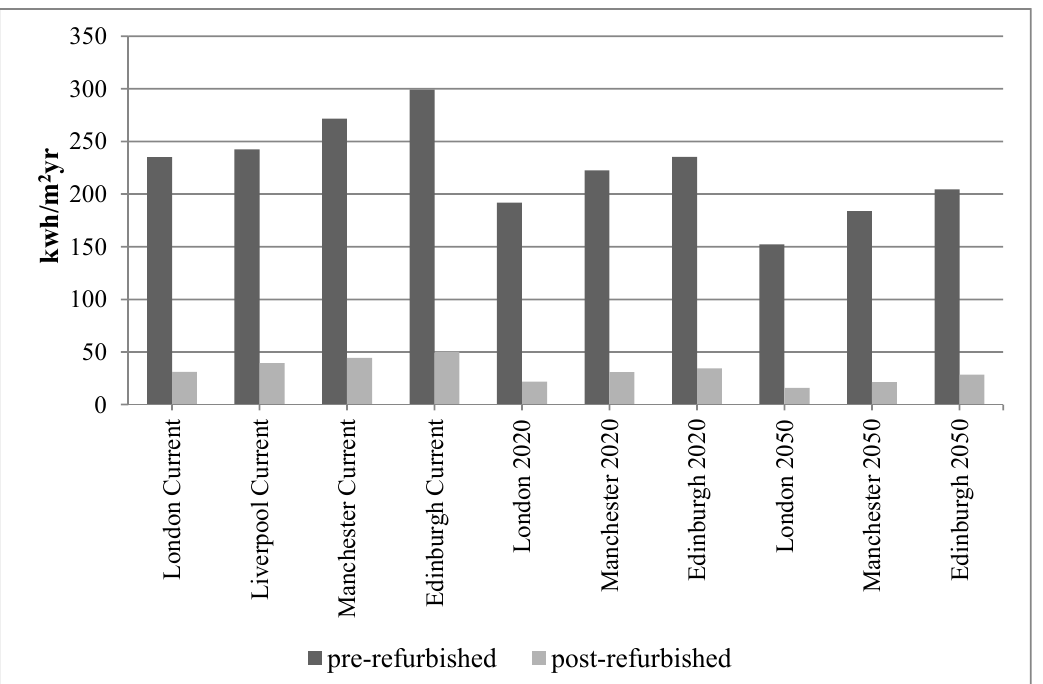
Figure 7. Annual heating demand for the pre and post-refurbished terrace house in different cities for current and future weather